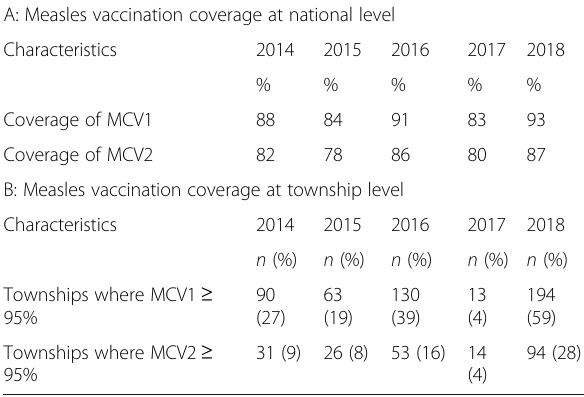
Table 3 Measles vaccination coverage in Myanmar: 2014 – 2018 A: Measles vaccination coverage at national level